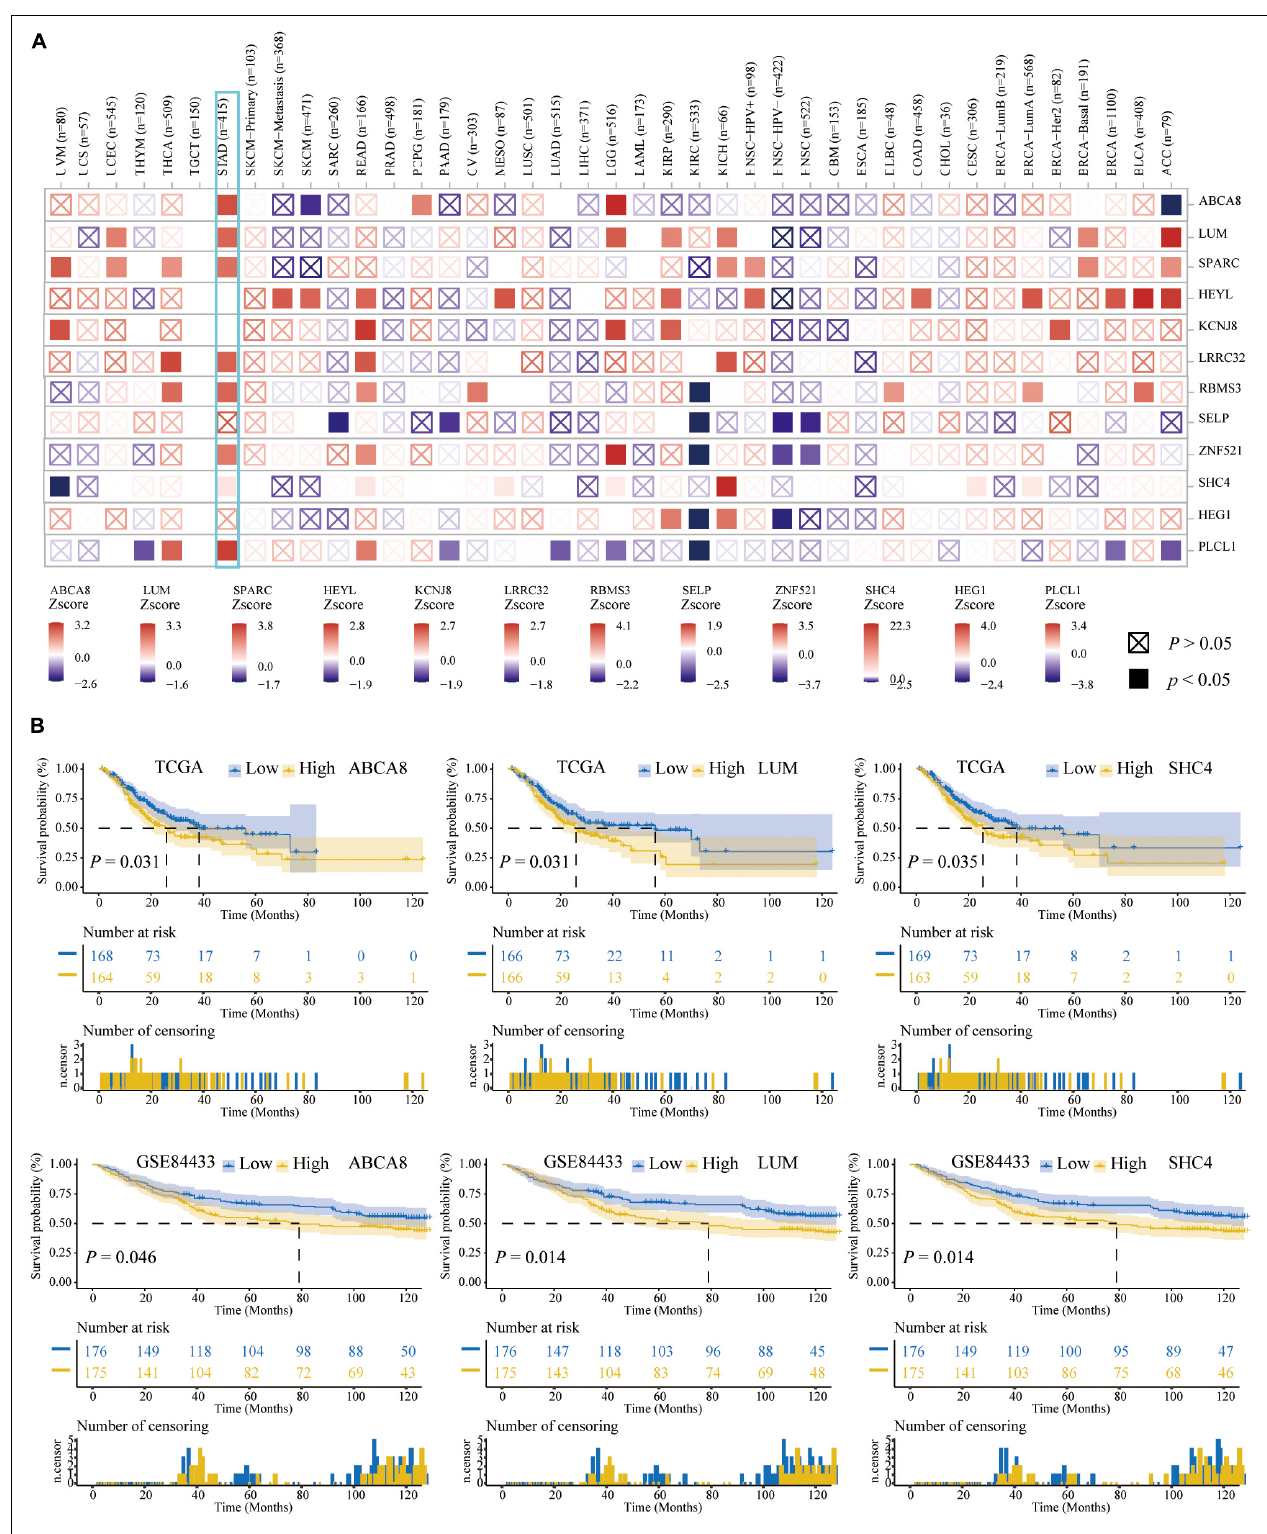
FIGURE 5 | Three key genes among 12 candidate genes. (A) Multivariate Cox analysis adjusted the influences of age, gender, race, stages, and tumor purity on the TIMER2.0 website. (B) Survival curves of the 3 key genes related to the OS of STAD patients among the 12 candidate genes. The higher the expression of 3 key genes, the shorter the OS of STAD